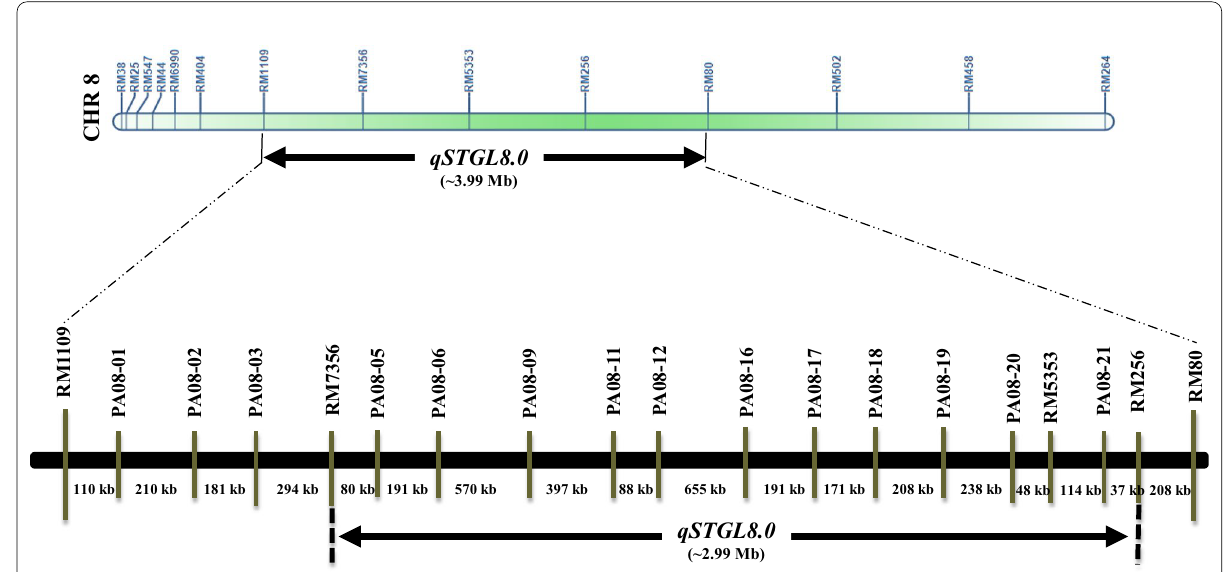
Fig. 3 The qSTGL8.0 locus with flanking markers . qSTGL8.0 detected between SSR markers RM7356 and RM80 (~ 3.99 Mb) using 357 BC 2 F 2 segregants derived from IR64 OL; was narrowed down to 2.99 Mb by using newly designed InDel ×